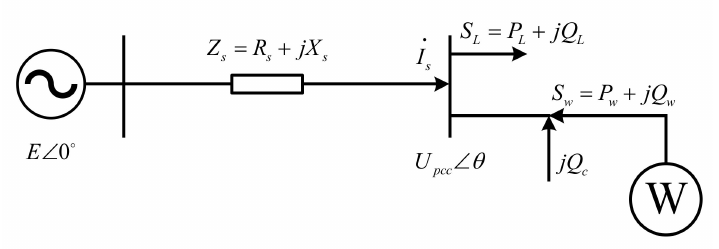
Figure 2. The equivalent model of the power grid integrated with wind